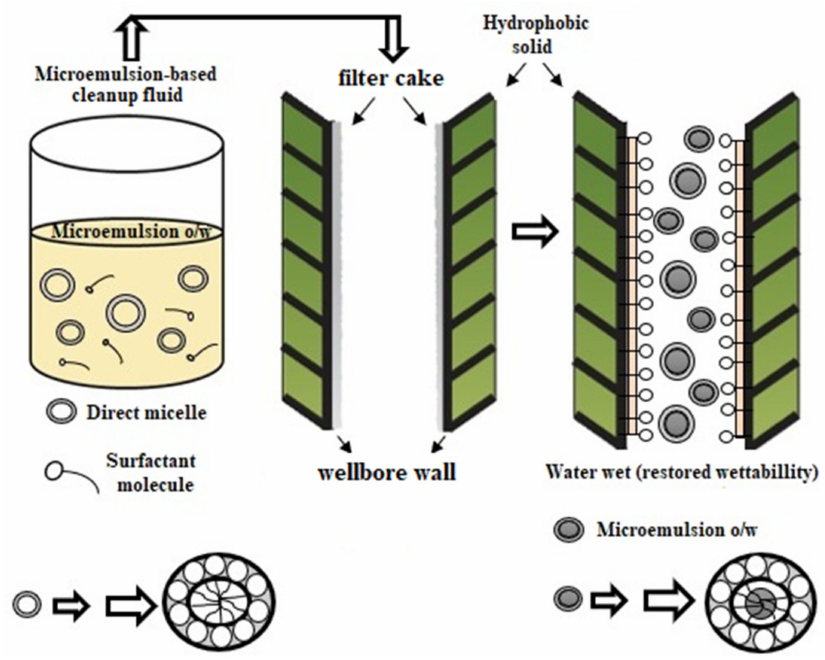
Figure 6. Wettability inversion mechanism.